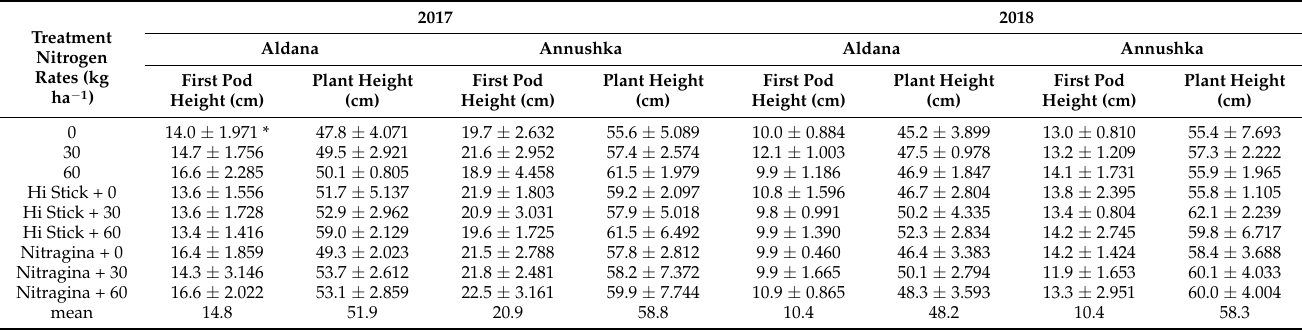
Table 5. Morphological features depending on the mineral N fertilization applied and the inoculation.